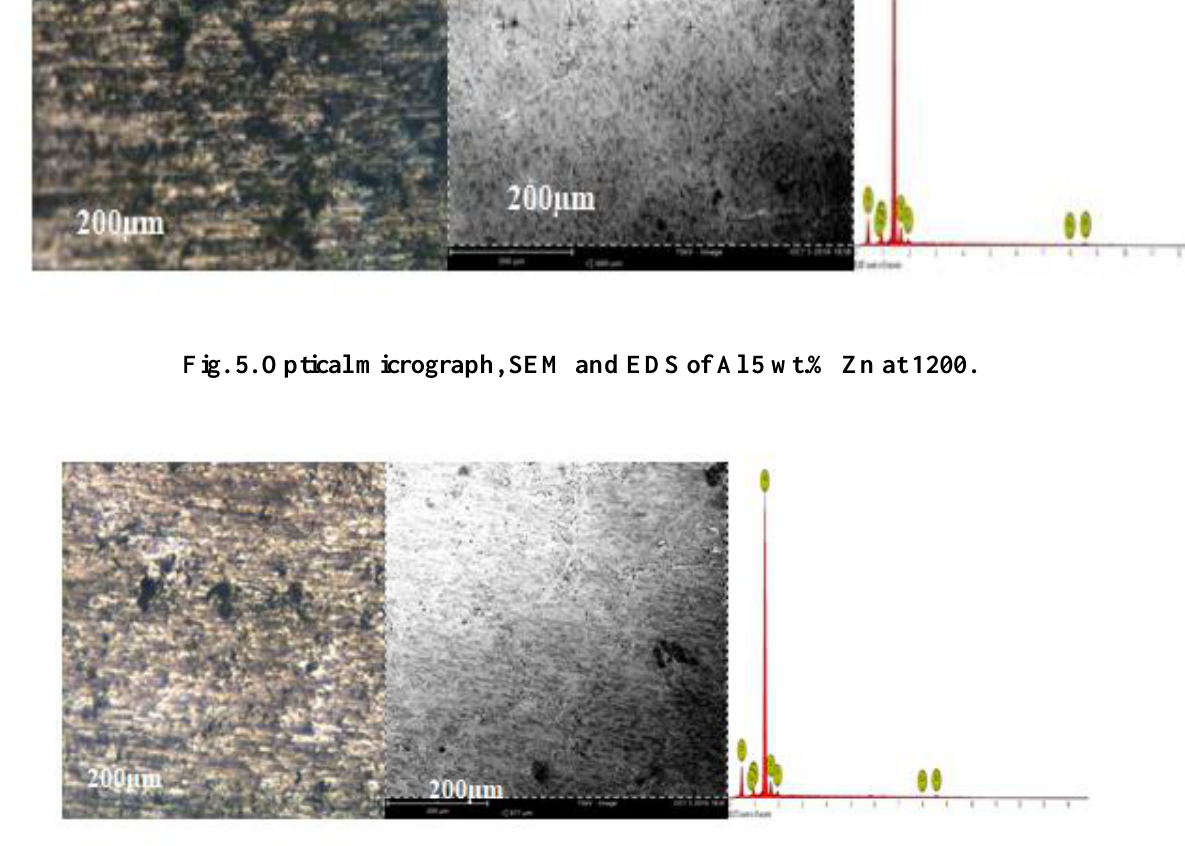
Fig. 6. Optical micrograph, SEM and EDS of Al 5 wt. % Zn at